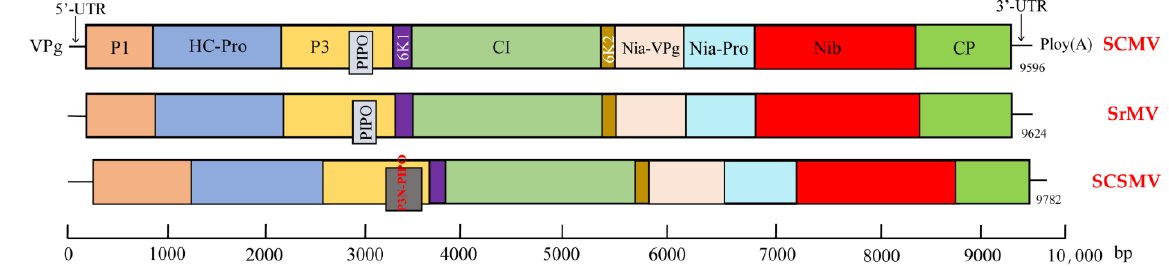
Figure 3. The genome structures of sugarcane mosaic viruses. Note: the reference genomes SCMV, SrMV, and SCSMV were assembled based on NC003398, NC004035 and GQ388116, respectively. P1, Protein 1; HC-Pro, Helper component proteinase; P3, Protein 3; PIPO, Pretty interesting Potyviridae ORF; 6K1, Protein 6K1; CI, Cylindrical inclusion protein; 6K2, Protein 6K2; VPg, Viral protein genome-linked; NIa-Pro, Nuclear inclusion a protein; NIb-Pro, Nuclear inclusion b protein; CP, Coat protein; P3N-PIPO, P3 N-terminus Pretty interesting Potyviridae ORF.